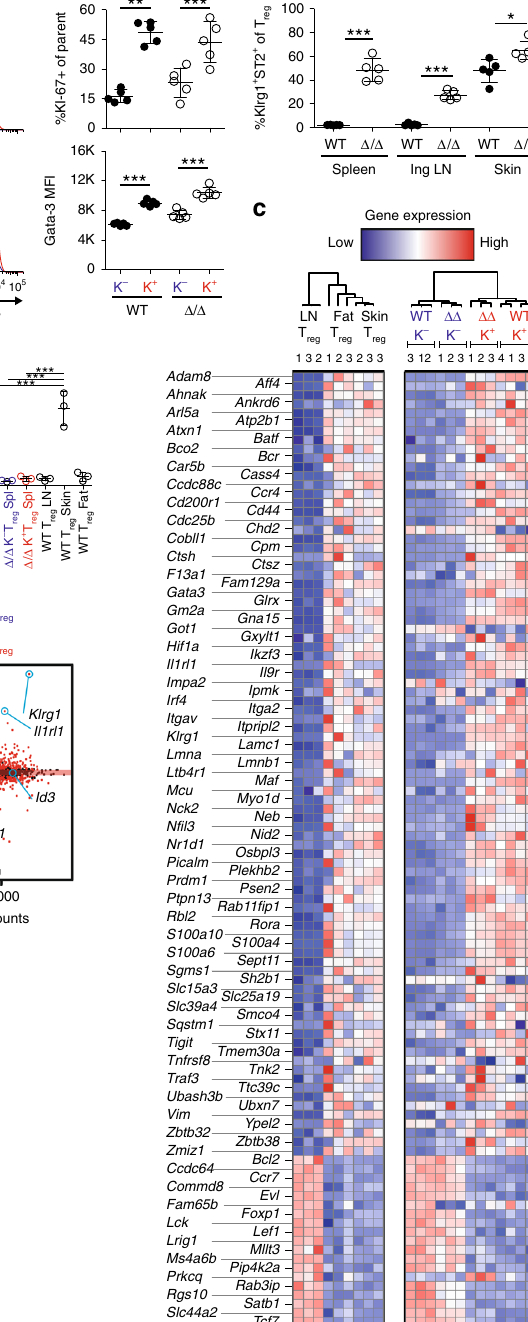
Fig. 7 Enrichment of ST2 + Klrg1 + Treg cells in affected Δ / Δ animals. a T reg cells (CD4 + CD45 + CD25 + Foxp3 + ) identi fi ed in spleens from WT vs. affected Δ / Δ animals and sub-gated for presence of ST2 + Klrg1 + tisT reg ST2-like cells (representative pseudocolor plots to the left). Middle, histograms illustrating KI-67 and Gata-3 expression in ST2 + Klrg1 + (K + ) vs. ST2 − Klrg1 − (K − ) T reg cells from WT and affected Δ / Δ animals, quanti fi cation to the right ( n = 5, unpaired t -test). b Quanti fi cation of ST2 + Klrg1 + T reg cells in spleen, inguinal LN and skin of WT and affected Δ / Δ animals (% of T reg , n = 5, unpaired t - test). c RNA sequencing from spleen Δ / Δ Klrg1 + T reg cells ( Δ / Δ K + T reg , red), Δ / Δ Klrg1 − T reg cells ( Δ / Δ K − T reg , blue), WT Klrg1 + T reg cells (WT K + T reg , red), and WT Klrg1 − T reg cells (WT K − T reg , blue). Expression of 106 tisT reg ST2 signature genes derived from a previous study 7 in a heatmap with column dendrogram clustering. The expression of these signature genes in T reg cells from fat, skin and LN T reg cells shown to the left (Fat/Skin/LN WT T reg ). Heatmap and dendrogram created using R and heatmap function. d Expression of Il10 , Areg , Pparg , and Gpr55 in WT T reg cells from skin, fat, or LN versus spleen (spl) Δ / Δ Klrg1 + T reg , spleen Δ / Δ Klrg1 − T reg , and spleen WT Klrg1 − T reg cells. Statistical analysis of RNA-seq data described in Methods section. e MA plots illustrating expression of genes in two comparisons. Left, spleen WT Klrg1 + T reg cells vs. spleen Δ / Δ Klrg1 + T reg cells; right, spleen WT Klrg1 − T reg cells vs. spleen Δ / Δ Klrg1 + T reg cells. Individual genes are highlighted. Numbers indicate signi fi cantly expressed genes in the respective comparison. Data are representative of two or more independent experiments with individual mice ( a , b ) or a single experiment with several individual mice ( c – e ). Source data are provided as a Source Data fi